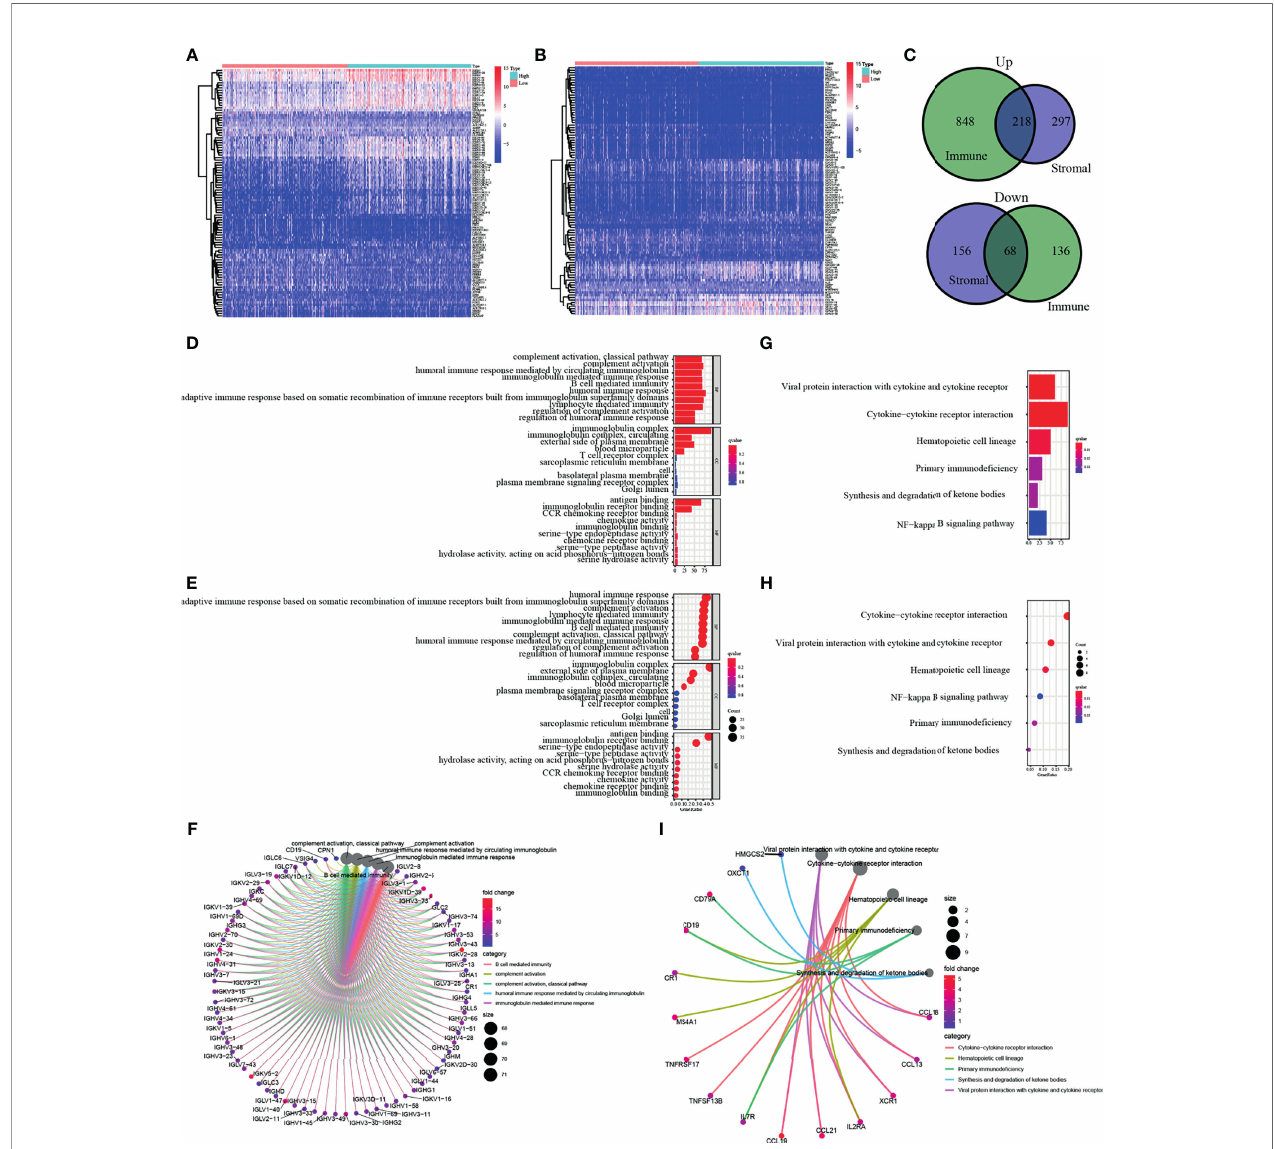
FIGURE 3 | Enrichment analysis of differentially expressed genes (DEGs). DEGs of two immune-related ingredients in tumor microenvironment (TME) were shown in panels (A, B). In panel (C) , a total of 286 genes shared by the ImmuneScore and StromalScore. (D – F) Result of Gene Ontology (GO) enrichment analysis. (G – I) Kyoto Encyclopedia of Genes and Genomes (KEGG) enrichment analysis of